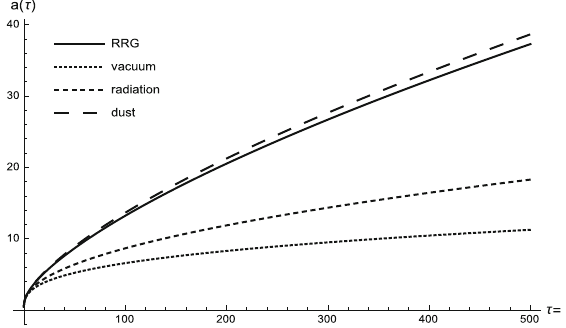
= Fig. 5 Plots of scale factors for the moderate warmness. Parameters ani are as follows: b = 0 . 5, Ω